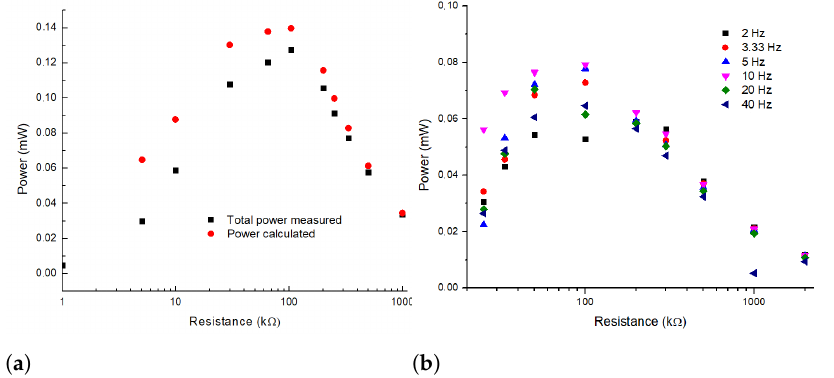
Figure 9. BERS power characterisation. The total power was measured using a standard multimeter while the power is calculated by adding all the individual MFC power outputs: ( a ) power curve of the BERS using MFCs 1–6; ( b ) power curve of the BERS using MFCs 1–4 for various frequencies.